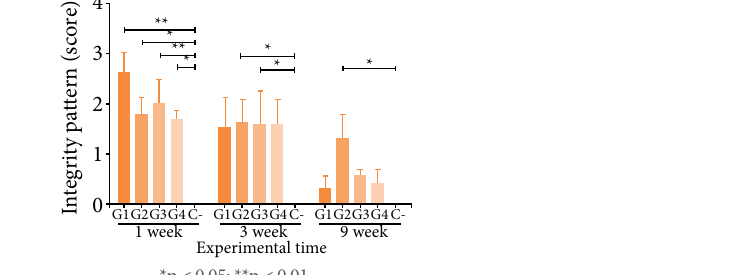
Figure 6 - Integrity of poultry collagen-based hydrogels in subcutaneous tissue in mice at one, three and nine weeks. Osteoconductivity